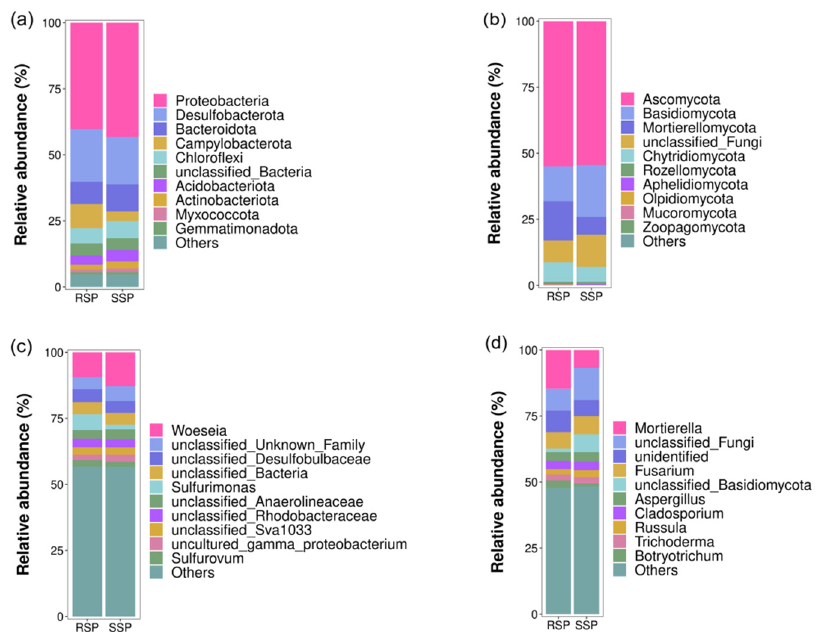
Figure 3. The relative abundance of the top 10 bacterial ( a , c ) and fungal ( b , d ) taxa at the phylum ( a , b ) and genus ( c , d ) level.